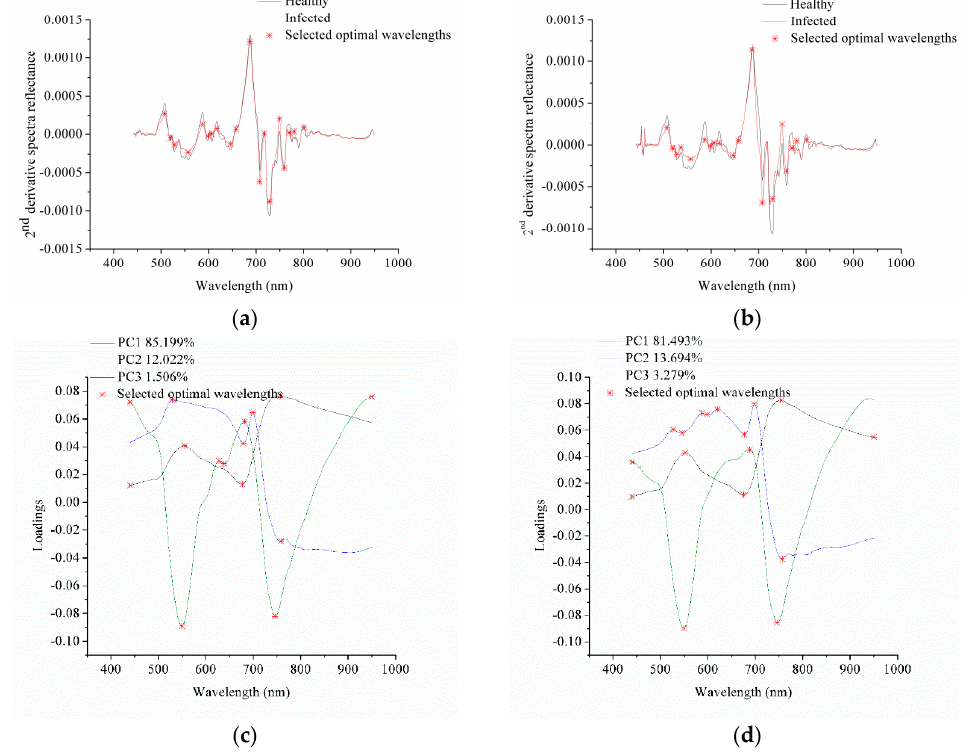
Figure 4. Optimal wavelengths selection of sample set 1 and 2 by 2nd derivative spectra ( a , b ) and the PCA loadings ( c , d ).